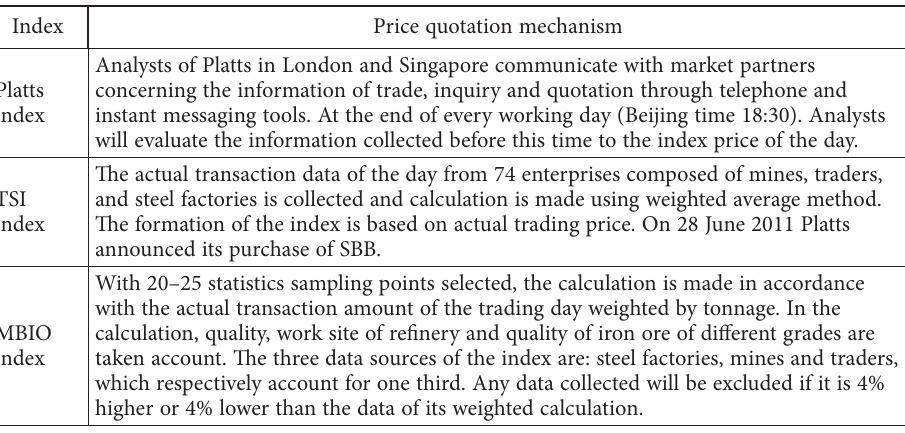
Table 2. Comparison of the three iron ore price indexes